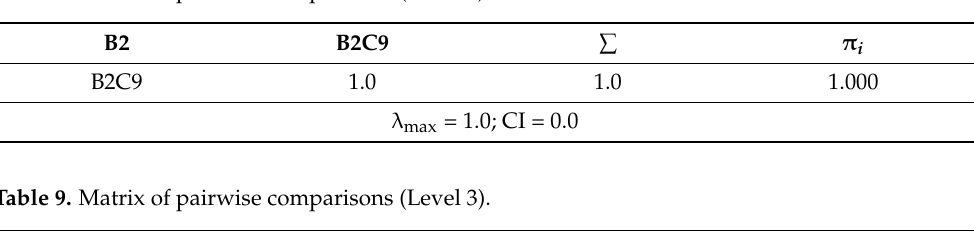
Table 8. Matrix of pairwise comparisons (Level 3).